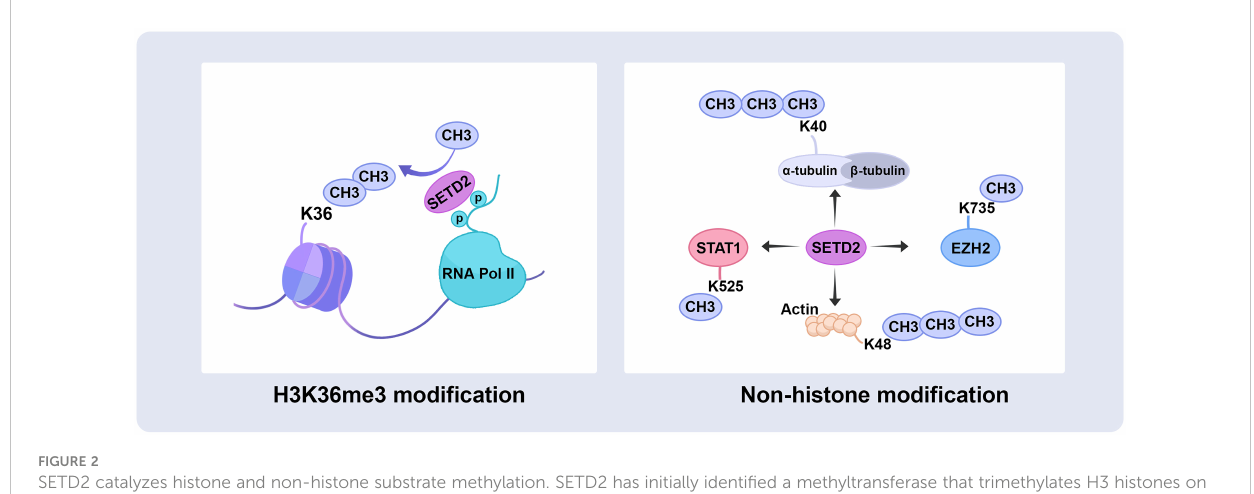
FIGURE 2 SETD2 catalyzes histone and non-histone substrate methylation. SETD2 has initially identi fi ed a methyltransferase that trimethylates H3 histones on lysine 36, also occurs on the non ‐ histone substrate, trimethylates a -tubulin at lysine 40 and actin at lysine 68, as well as methylates STAT1 at lysine 525 and EZH2 at lysine 735. RNA Pol II, RNA polymerase II; STAT1, signal transducer and activator of transcription 1; EZH2, enhancer of zeste homolog